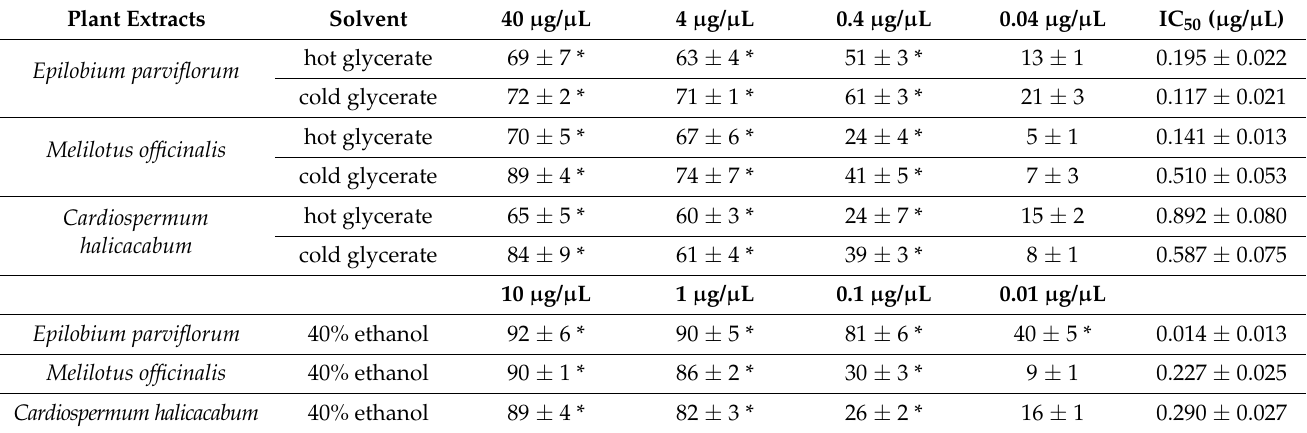
Table 2. Antioxidant effect of different dilutions of the plant extracts Epilobium parviflorum , Melilotus officinalis , and Cardiospermum halicacabum prepared in hot and cold glycerate and 40% ethanol. Plant